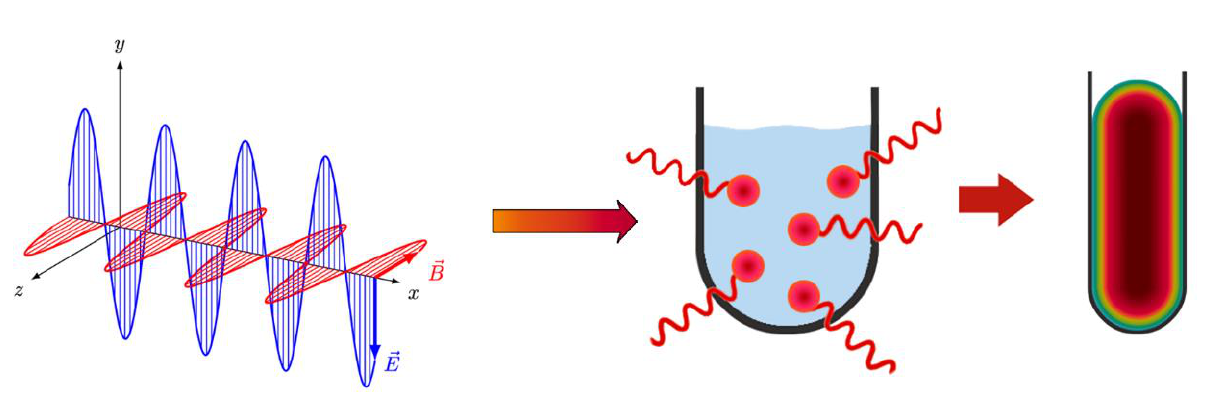
Figure 1. Process of MW heating: microwave radiation interacts directly with the reaction mixture and induces instantaneous localized superheating, which leads to an even heat distribution throughout the mixture.